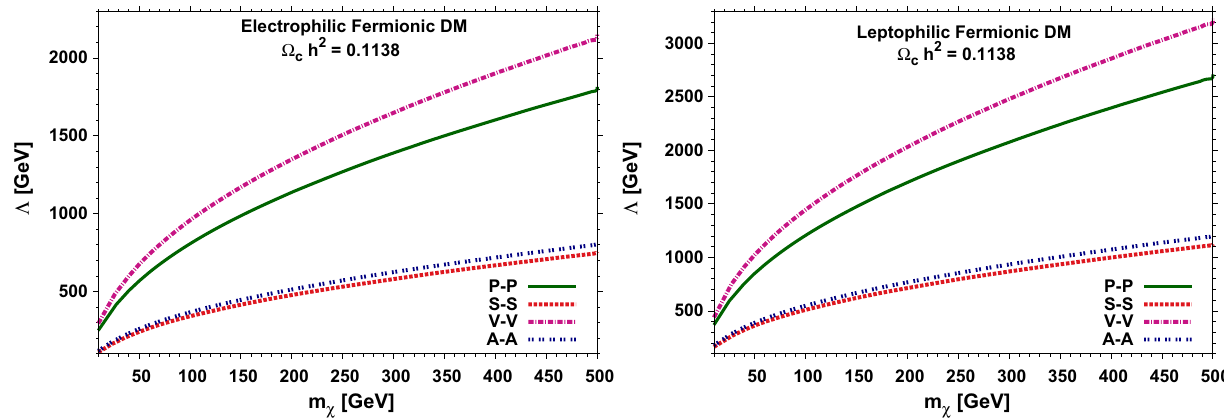
Fig. 1 Contours in the Λ – m χ plane based on the cold dark matter den- sity Ω c h 2 = 0 . 1138 ± 0 . 0045 obtained from the 9-year WMAP data [45].Herewehavetaken α l